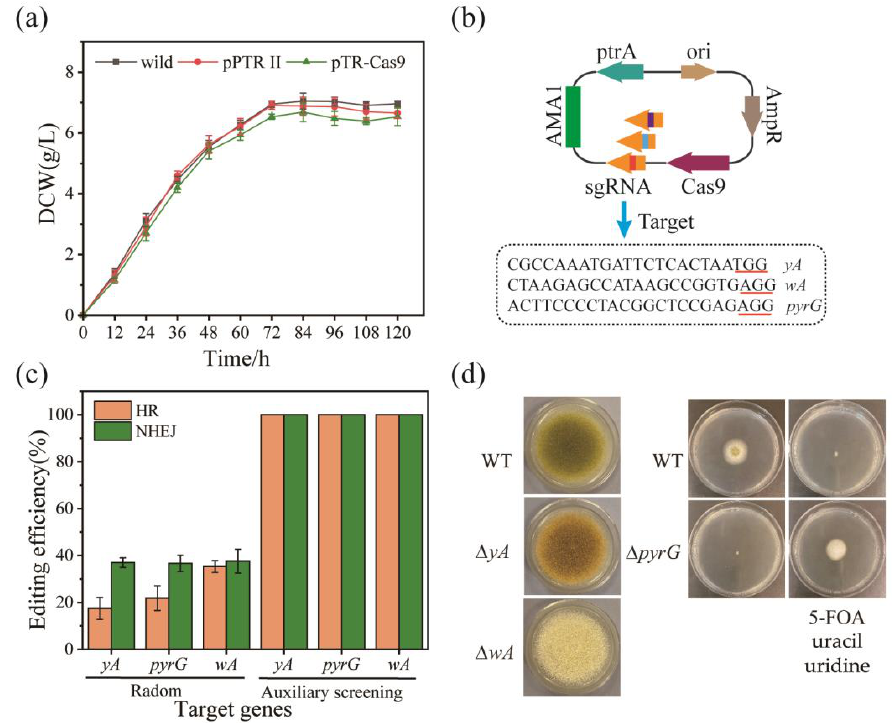
Figure 2. CRISPR/Cas9 mediated single-gene editing in A. oryzae . ( a ) The effect of Cas9 protein on the growth of A. oryzae . ( b ) Schematic diagram of editing plasmids and their target sequences. The bases underlined in red represent the protospacer adjacent motif (PAM) sequence. ( c ) The editing efficiency of related genes by CRISPR/Cas9 system. In experiments based on HR repair, donor DNA is the homology arm that deletes large fragments of CDS. n = 5. ( d ) Phenotypes of yA , wA , and pyrG mutants were generated from the wild strain. Wild-type A. oryzae cannot grow normally on the plate in the presence of 5-FOA, while the pyrG mutant strain can grow normally when additional uracil and uridine are needed. Mutants of the yA gene encoding conidial laccase form yellow conidia, whereas wA mutants form white conidia due to the lack of the polyketide synthase required for conidia